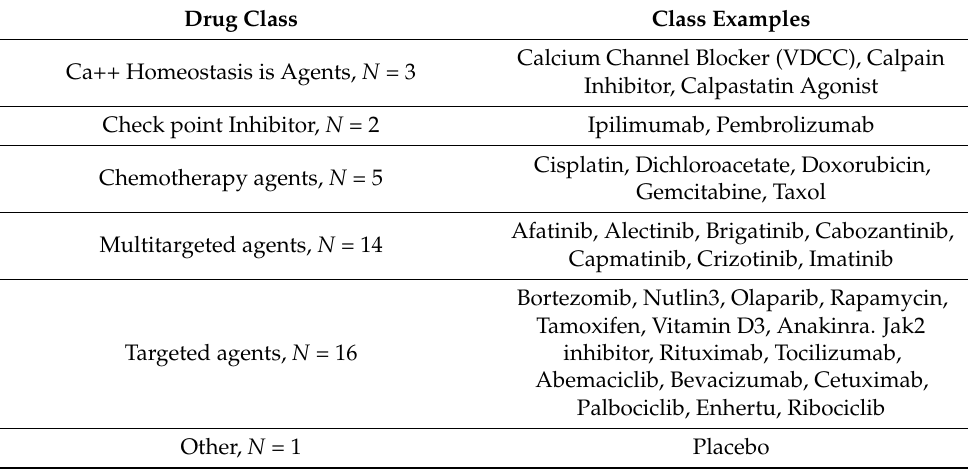
Table 4. Summary of the drugs included in this repurposing